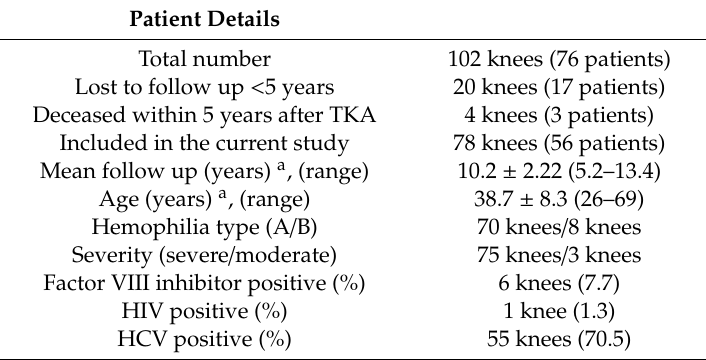
Table 1. Demographic characteristics.